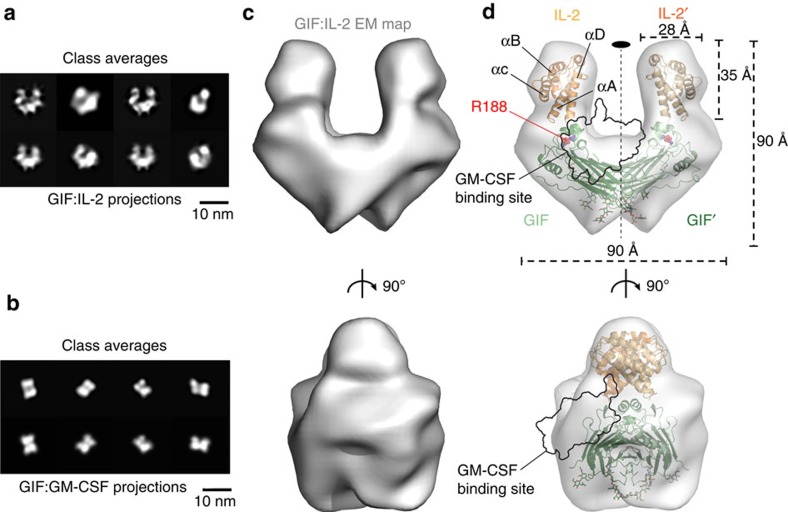
Structural analysis of GIF:IL-2 and GIF:GM-CSF complexes by negative-stain EM.(a) Gallery of representative ab initio class averages of the GIF:IL-2 complex and projections of the final 3D reconstruction under similar orientations. (b) Ab initio class averages of the GIF:GM-CSF complex and projections of the GIF:GM-CSF crystal structure under similar orientations. (c) Front and side views of a 3D reconstructed EM map for the GIF:IL-2 complex. The 3D volume displays a characteristic horseshoe shape. (d) Fit of the crystal structure of dimeric GIF and a homology model of ovine IL-2 in the corresponding EM map. The resulting model displays a horseshoe shaped complex formed by a GIF dimer bound by two copies of IL-2 (GIF dimer: green/dark green, IL-2: orange/dark orange) and displays a two-fold symmetry axis centered at the GIF dimer interface, indicated as a black oval.